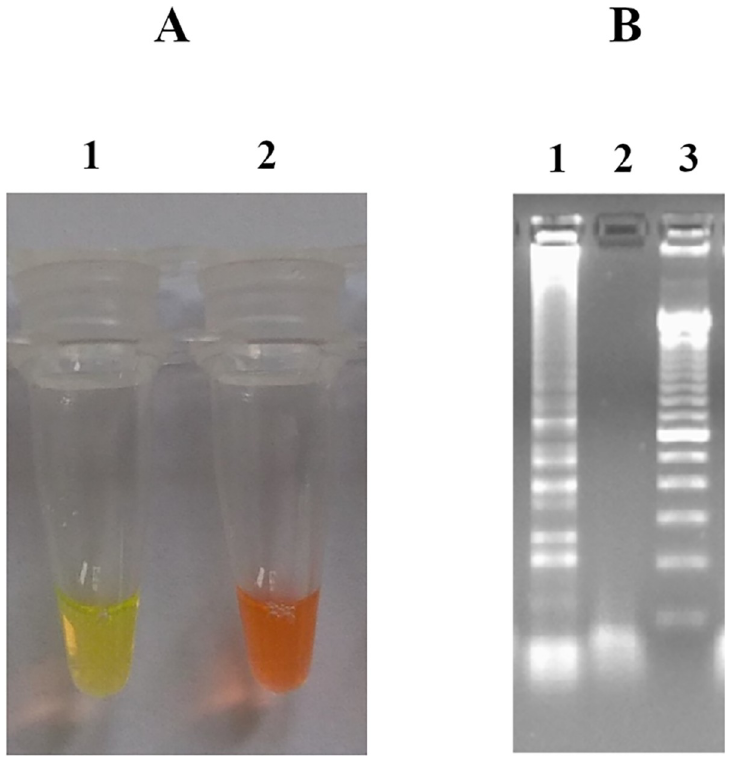
Fig 1. Visualization of LAMP products. (A) stained with SYBR Green I and observed under natural light (Tube 1: Y . pestis , Tube 2: negative control); (B) with agarose gel electrophoresis (Lane 1: Y . pestis , Lane 2: negative control, Lane 3: DNA ladder marker 100 bp).